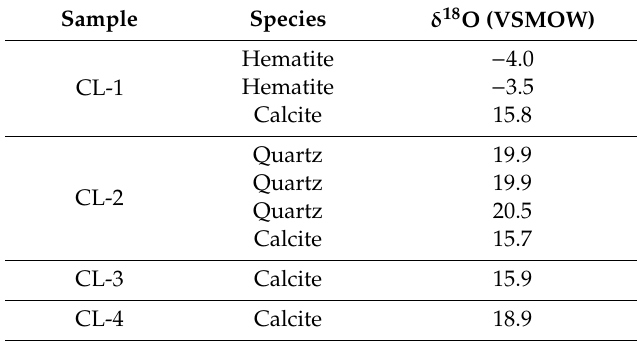
Table 1. Stable oxygen isotope ratios for calcite, hematite, and quartz from the Chub Lake prospect. Measurements made by Julia Cox, University of Georgia. VSMOW—Vienna Standard Mean Ocean